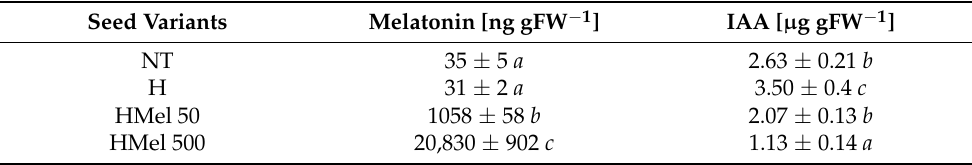
Table 1. Effect of different seed hydropriming treatments on melatonin and IAA content in maize seeds. Seeds were hydroconditioned with water (H) or with melatonin water solution at concentra- tions: 50 and 500 µ M (HMel 50 and HMel 500 respectively). Control seeds were not primed (NT). The results were expressed as means of 9–12 measurements ± SEM. One-way ANOVA and Duncan’s post-hoc test were performed. The lowercase letters next to the values show the statistical significance at the specified p . Seed